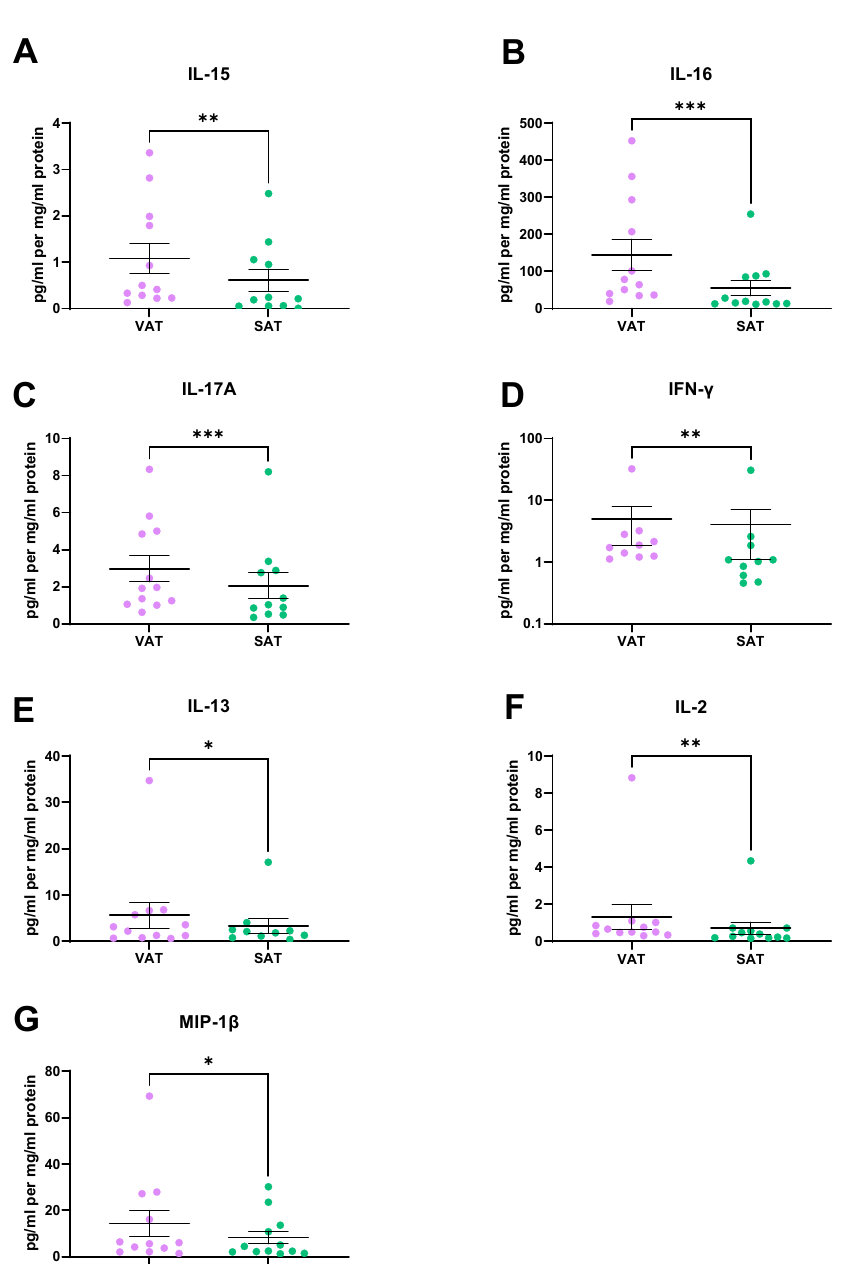
Figure 6. Inflammatory, cytokine, and chemokine secretions are higher in the visceral adipose tissue (VAT) secretome when compared to subcutaneous adipose tissue (SAT) secretome. There were significantly higher levels of ( A ) IL-15, ( B ) IL-16, ( C ) IL-17A, ( D ) IFN- γ , ( E ) IL-13, ( F ) IL-2, and ( G ) MIP-1 β secreted from VAT when compared to SAT. All data expressed as mean ± SEM. Statistical analysis was performed using a Wilcoxon signed rank test. n = 12 paired samples for IL-16, IL-2 and MIP-1 β , n = 11 paired samples for IL-17A and IL-15, n = 10 paired samples for IFN- γ and IL-13. *** p < 0.001, ** p < 0.01, * p < 0.05.